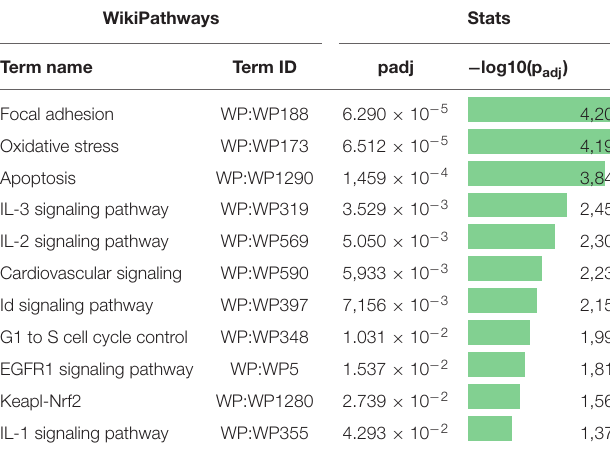
TABLE 2 | Pathway enrichment analysis of downregulated miRNA target gene set in the WikiPathways database.